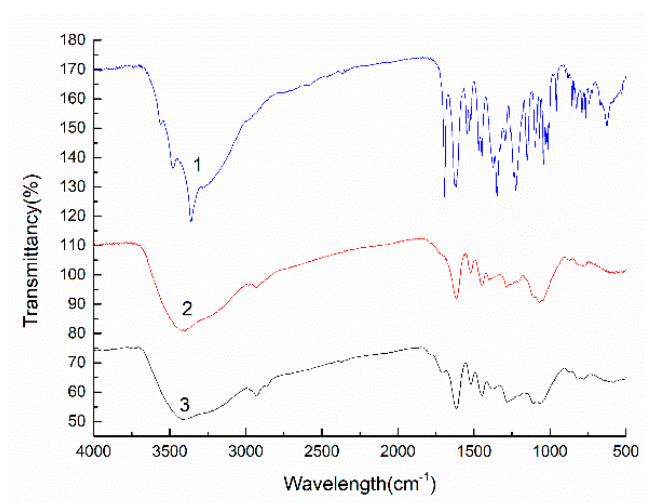
Figure 4. IR spectra of catechin standard (1), LOPC (2) and LPPC (3).